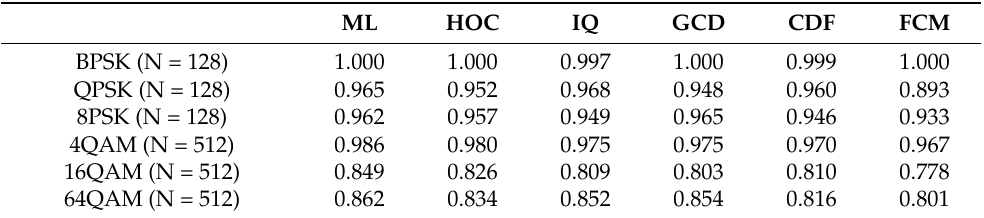
Table 4. Average correct classification probability of each modulation scheme of different features under Gaussian